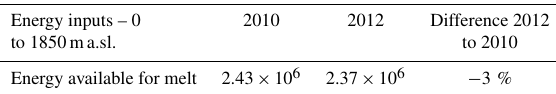
Table 1. Energy inputs in 2010 and 2012